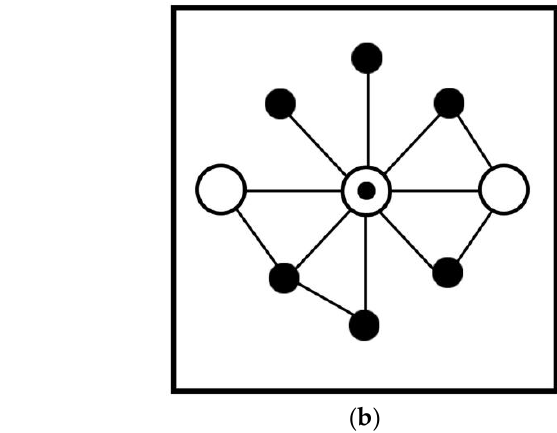
Figure 16. ( a ) Spatial pattern of the city network in the northern GBM Delta. Source: the authors; Base Map: Google satellite map; Reference: [65]; ( b ) Hub pattern dominated by regional transportation. Source: the authors.